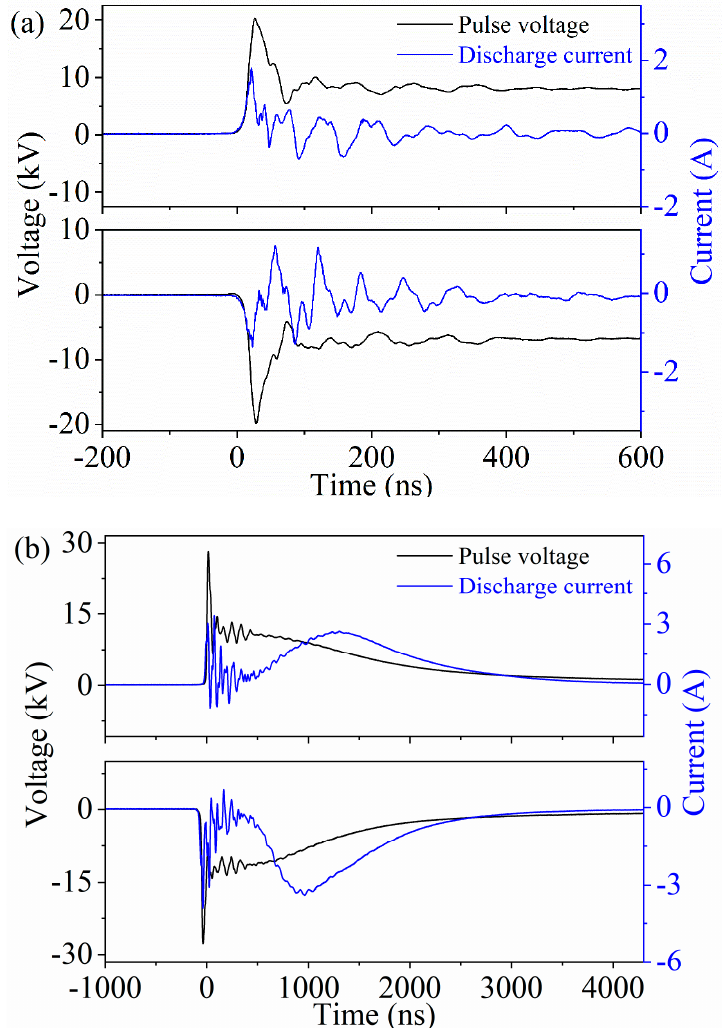
Figure 3. Waveforms of the pulse voltage and discharge current at ( a ) 20 kV and ( b ) 28 kV with a 150 Hz pulse repetition